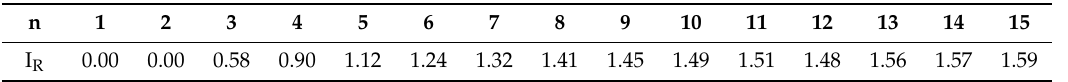
Table A7. Random Index, I R (Saaty, 2008).